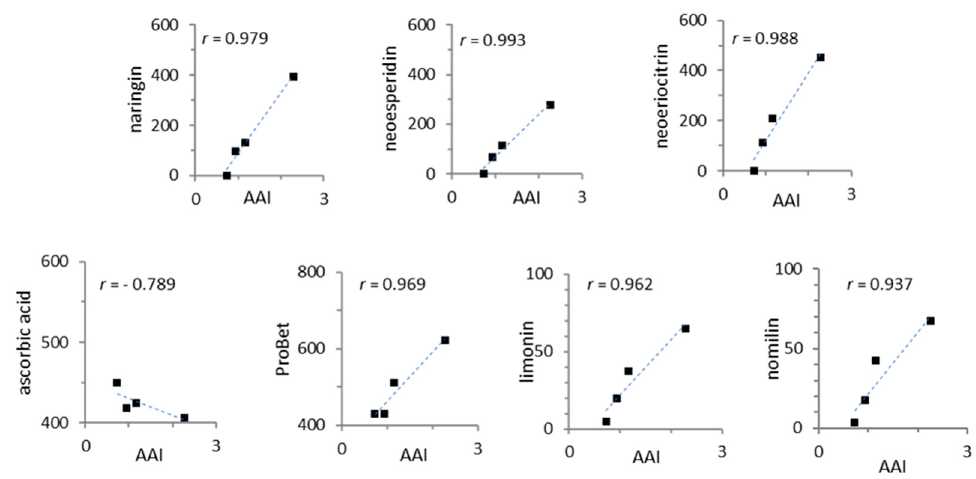
Figure 4. Pearson test correlation coefficients ( r ) among the antioxidant activity index (AAI) and the content (mg/kg) of flavanone glycosides, ascorbic acid, quaternary ammonium compounds, and limonoid aglycones in the BJ ( p < 0.05).